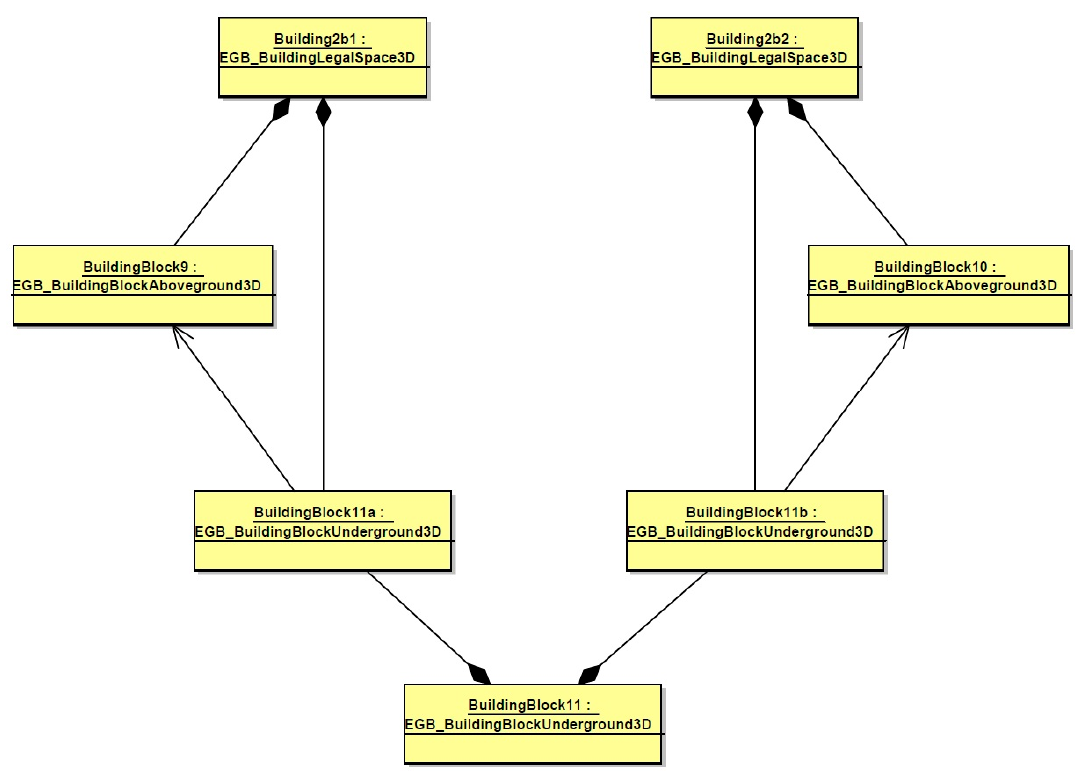
Figure 16. The UML schema of instance where underground part is divided between two properties.